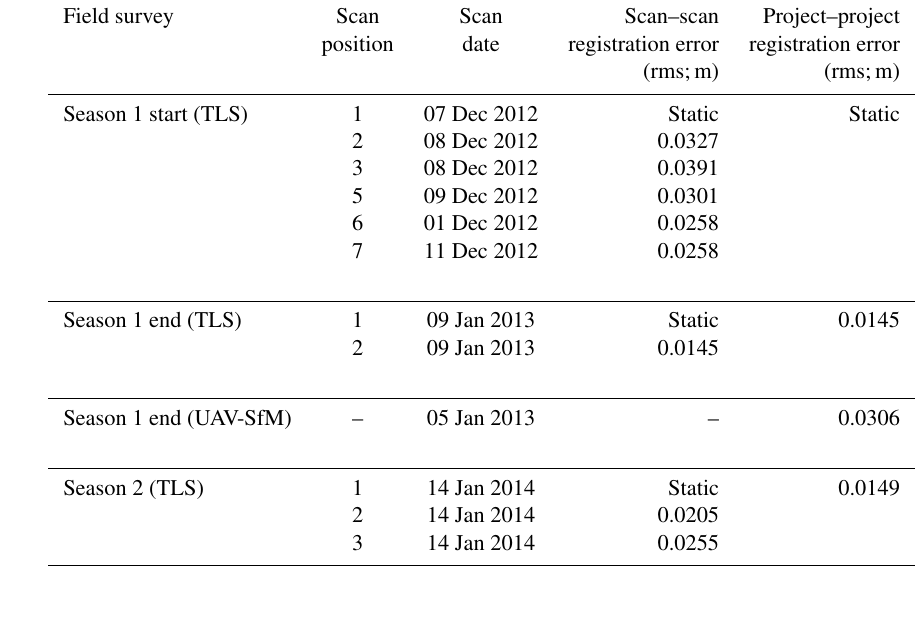
Figure 2. Field photographs of the Patriot Hills blue-ice moraine study site. (a) Panoramic photograph of the moraine embayment – view north-east towards the ice margin from the rear of the embayment. Area shown in (c) and position and view direction of camera (b) shown for reference. (b) View to the north-west with moraine crest in foreground and subdued, ice-marginal moraine surface topography in middle ground. (c) Close-up of moraine topography, highlighting ridges and furrows on moraine crests and in inter-moraine troughs. Table 1. Terrestrial laser scanning and UAV-SfM survey dates and registration errors. Within each season, individual scans were registered to a single static position to produce a single, merged point cloud (scan–scan registration error). TLS data from the end of season 1 and for season 2 were subsequently registered to TLS data acquired at the start of season 1, producing a project–project registration error. The UAV-SfM data (season 1 end) were registered to TLS data from the end of season